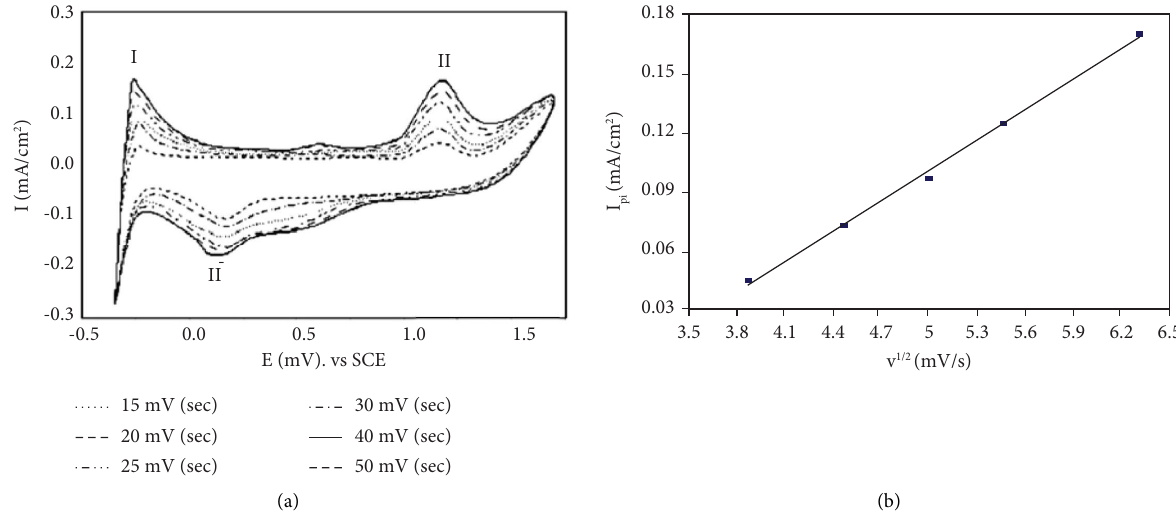
Figure 3: (a) Efect of the scan rate on the cyclic voltammograms for electropolymerization of SA from a solution containing 0.04 mol · L − 1 SA and 0.30mol · L − 1 H 2 SO 4 at 313K. (b) Relationship between I pi and v ½ .